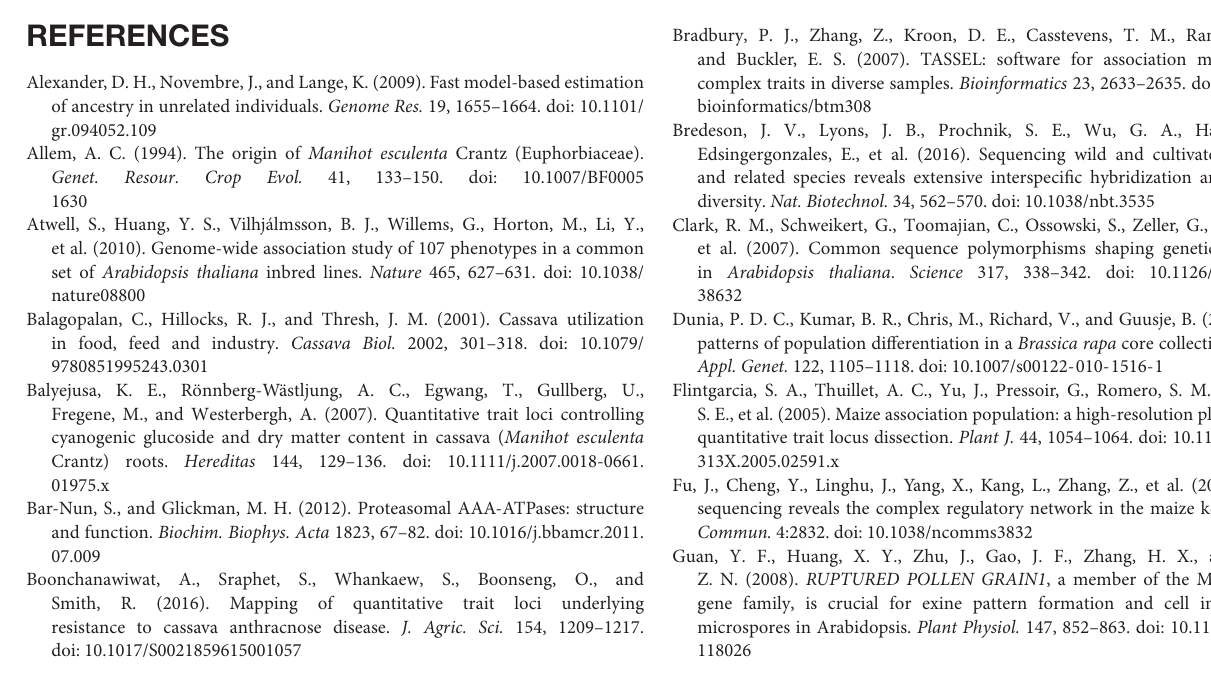
storage roots weight. (c) Manhattan plots of the compressed MLM for traits as in a. (d) Quantile–quantile plot of the compressed MLM for storage roots weight. FIGURE S13 | Genome-wide association analysis on leaf aspect ratio and lobular width in 158 cassava accessions using the SNPs detected on Chromosome 3. Genomic position ( x axis) is plotted against its significance expressed as − log 10 P value ( y axis). Genomic position covers 1 Mb on either side of the peak SNP, as shown in a black dashed vertical line. Genome-wide significance threshold is depicted as a blue horizontal dashed line. Annotated candidate genes are indicated in pink boxes below the graph. FIGURE S14 | Genome-wide association analysis on leaf aspect ratio and lobular width in 158 cassava accessions using the SNPs detected on Chromosome 10. Genomic position ( x axis) is plotted against its significance expressed as -log 10 P value ( y axis). Genomic position covers 1 Mb on either side of the peak SNP, as shown in a black dashed vertical line. Genome-wide significance threshold is depicted as a blue horizontal dashed line. Annotated candidate genes are indicated in pink boxes below the graph. FIGURE S15 | Genome-wide association analysis on leaf aspect ratio and lobular length in 158 cassava accessions using the SNPs detected on Chromosome 6.